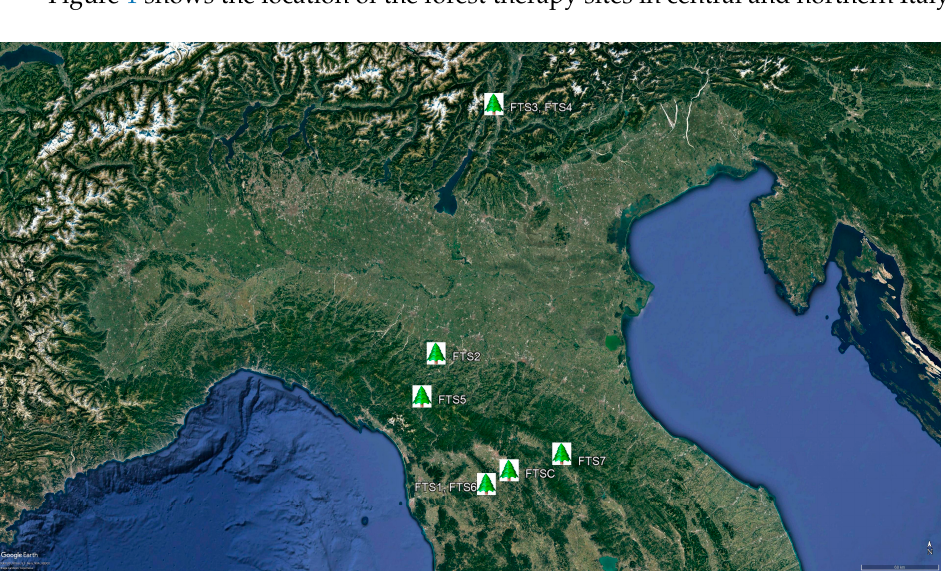
Figure 1. Locations of forest therapy sessions (FTS1 to FTS7 and FTSC) in central and northern Italy. During each session, the concentration of total volatile organic compounds (TVOCs) was continuously collected by means of a portable (0.72 kg) photoionization detector (PID, model Tiger VOC detector, Ion Science Ltd., Fowlmere, Royston, UK), with detection limits from 1 µ g/m 3 to 20,000 µ g/m 3 . The PID was equipped with a pump, sucking in ambient air at a rate of 220 mL/min, and an ultraviolet, 10.6 eV lamp, allowing the ionization of organic substances present in the sampled air, including all the monoterpenes (MTs) found in biogenic VOCs (BVOCs). The resulting electric current flowing between two electrodes was measured, amplified and transformed into a concentration level of the ionized substance or group of substances. TVOC concentration could be considered representative for BVOC concentration, although clearly higher due to the presence of VOCs other than MTs, at least at forest sites far from anthropogenic pollution sources where the change in TVOC concentration is mainly driven by plants’ emissions, as explained in a previous study